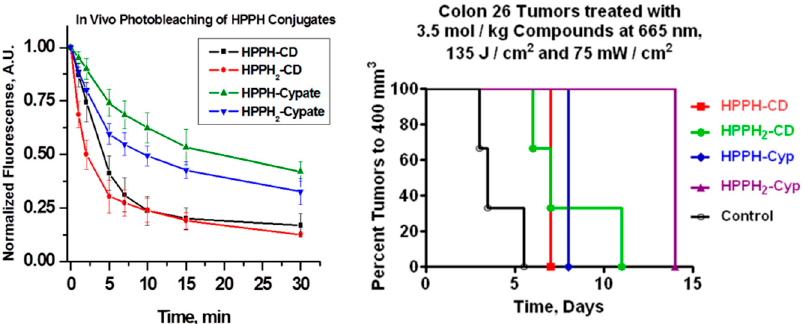
Figure 5. In vivo photobleaching of the conjugates: HPPH-CD 8 , HPPH 2 -CD 9 , HPPH-Cypate 10 and